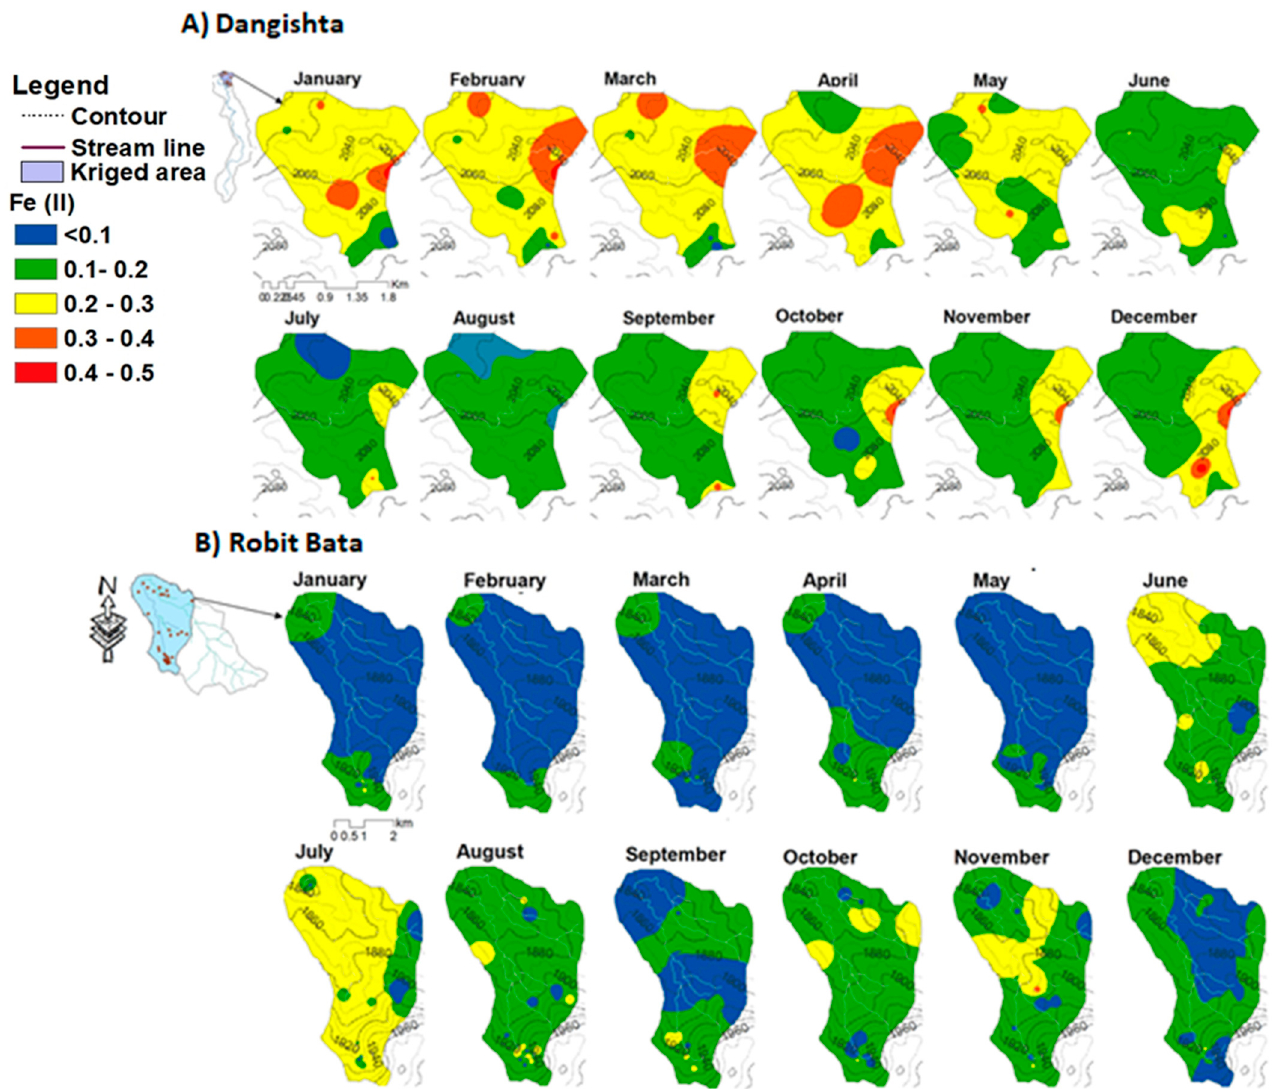
Figure 9. Monthly, kriged Fe 2 ⁺ concentration (2017 to 2018) in mg L − 1 in the aquifers of ( A ) Dangishta and ( B ) Robit Bata watersheds.